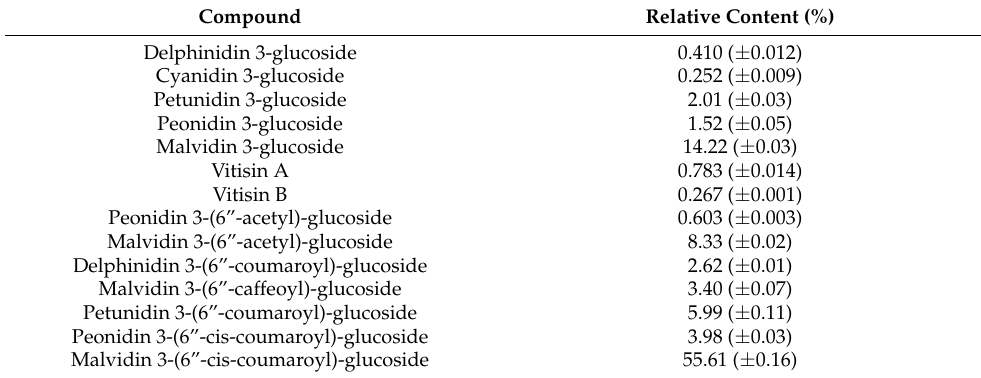
Table 16. Relative content of anthocyanins in the EtOH-H 2 O extract. The % was determined